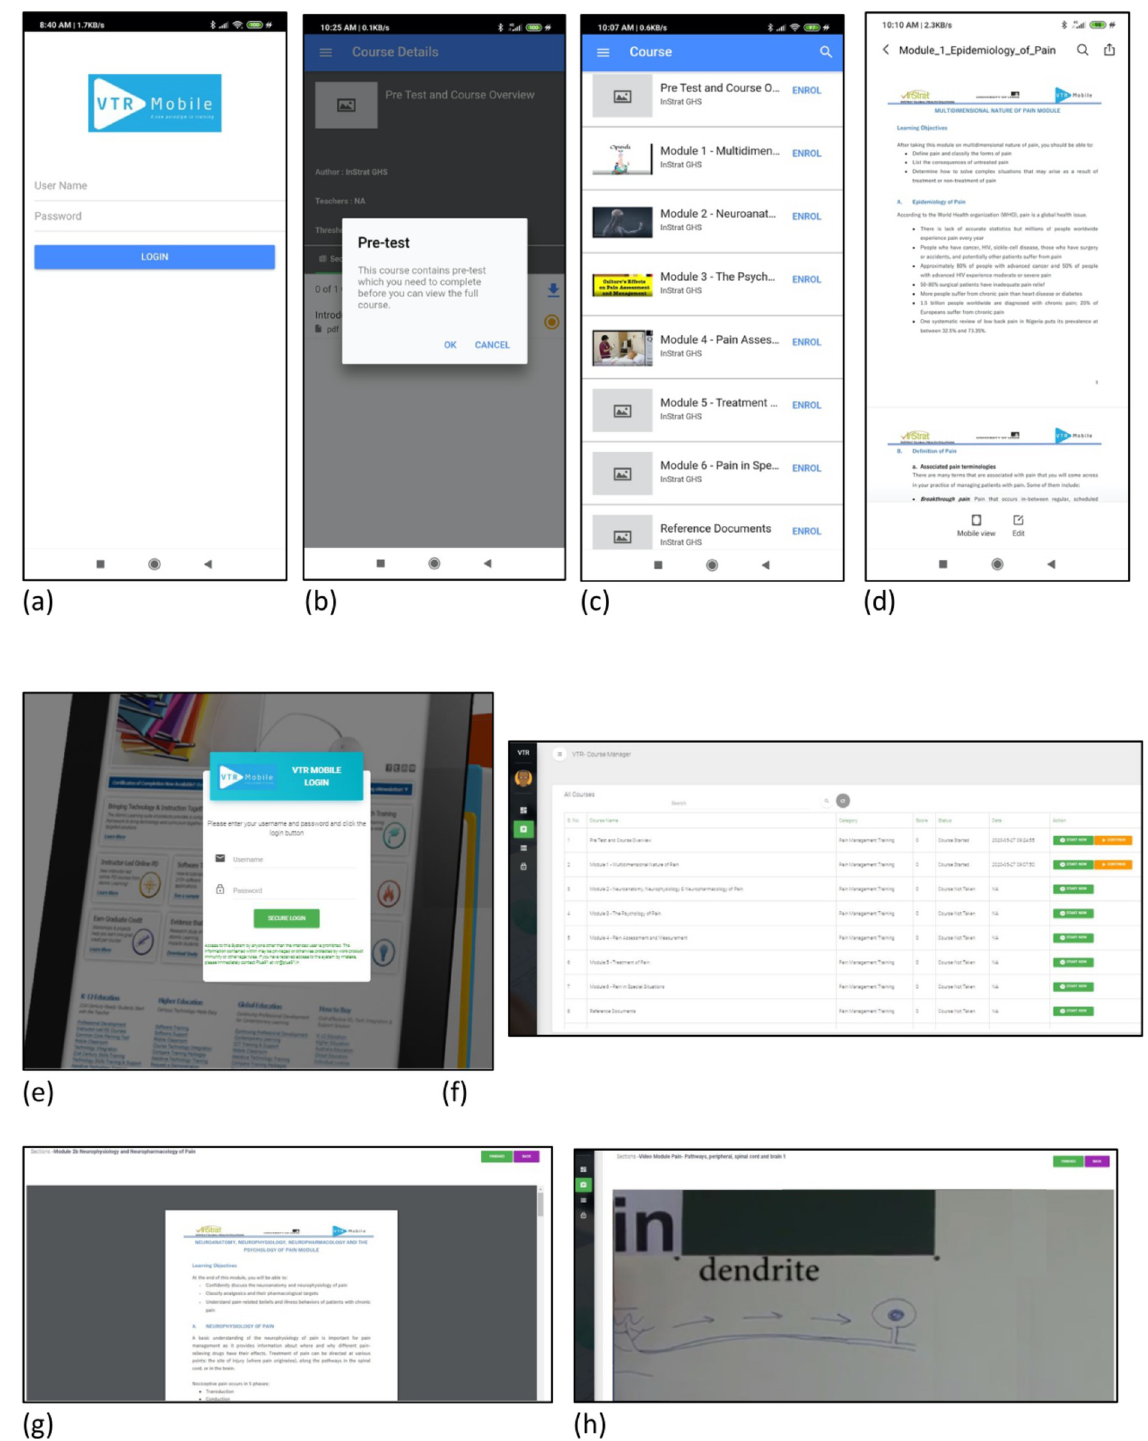
Fig 1. Screenshots of the interface for the VTR mobile app (a = login screen; b = pre-test notification; c = module list; d = example of written content) and the web application (e = login screen; f = module list; g = written content; h = video content).